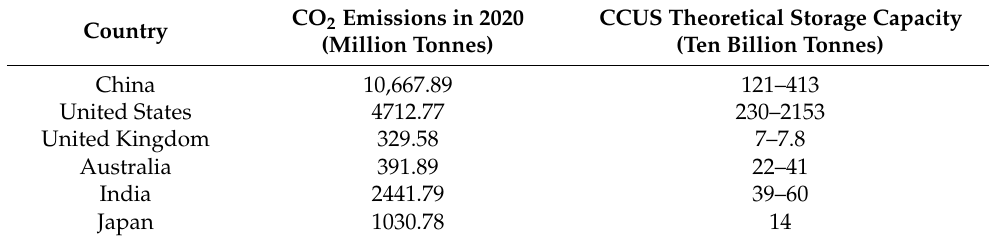
Table 2. Dominate CO 2 storage location and storage capacity in China [50].